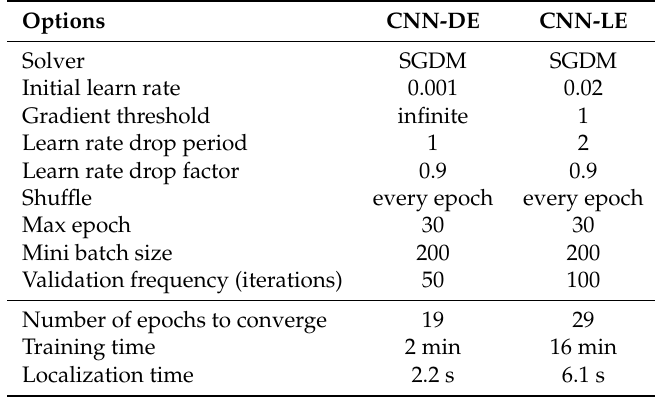
Table 4. CNN training options and time complexity